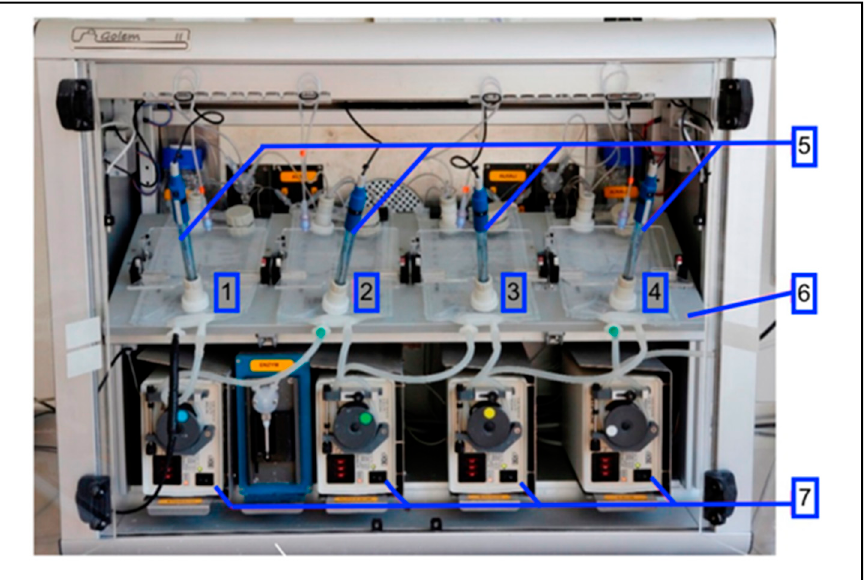
Figure 1. Golem v2 apparatus from front view: (1) stomach, (2) duodenum, (3) jejunum, (4) ileum, (5) pH probes, (6) heating platform, (7) peristaltic pumps.